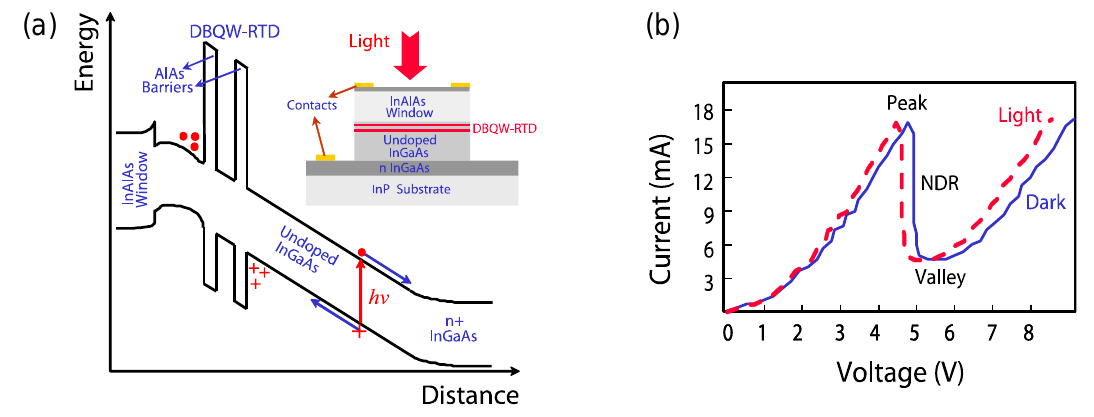
Figure 1. ( a ) Schematic of the conduction band diagram of a surface illuminated InGaAs/AlAs DBQW-RTD. Inset is shown the schematic cross-section of the surface RTD-PD [22]. ( b ) Typical dark and illuminated I-V